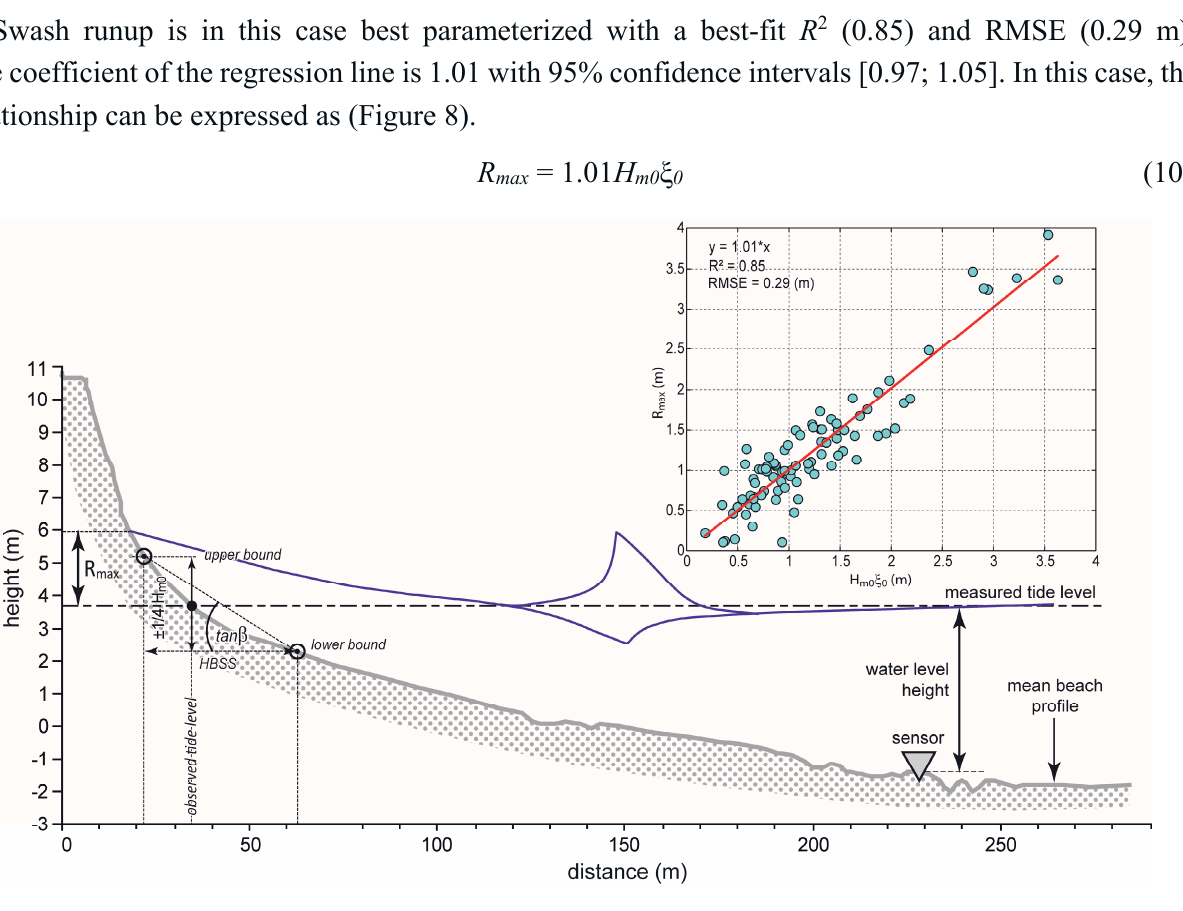
Figure 8. Method used to calculate beach slope for the runup calculation. It is based on measured tide level from which the beach section is defined. In contrast to the previous method, note that this approach is using the mean beach profile instead of daily beach